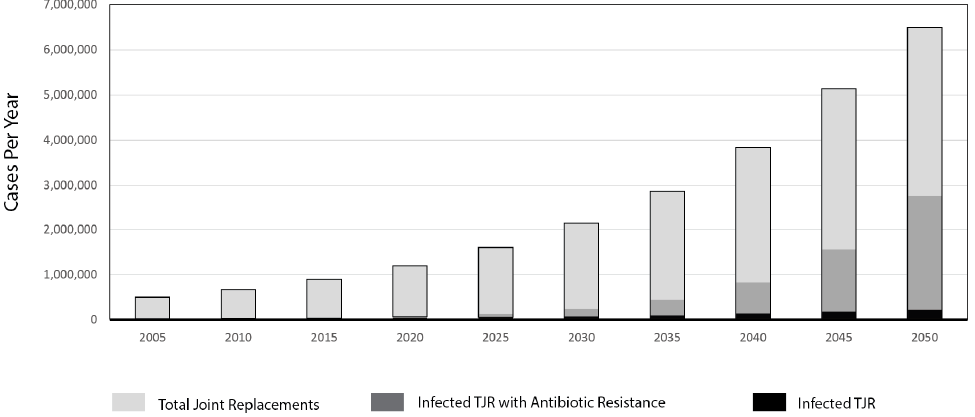
Figure 1. Projected total joint replacements (TJRs) with infection rates with and without the development of antibiotic resistance. Growth rate for TJRs was 6% annual growth and the growth rate for antibiotic resistance was 7% conforming with published numbers [9,16,18].